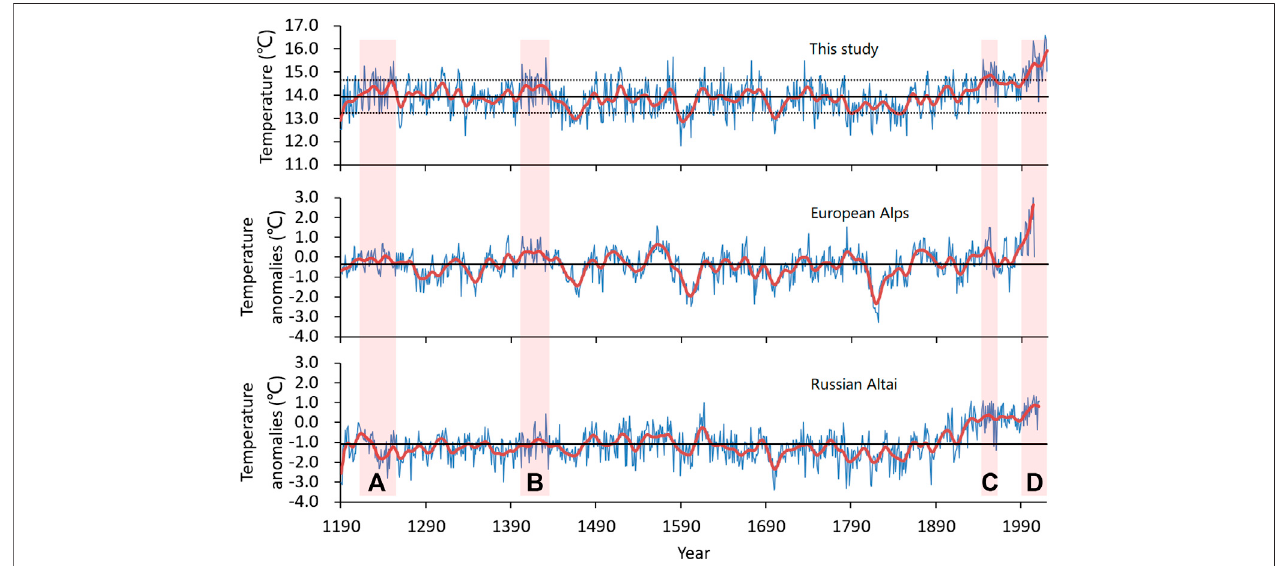
FIGURE 5 | Original (Thick) and 20-year low-pass fi ltered (thin) temperature reconstruction for northern Mongolian Plateau, the European Alps, and Russian Altai. The long-term average of the temperature reconstruction of northern Mongolian Plateau during 1190 – 2019 CE (13.9 ° C). The boxes mark important Asian historical landmarks: (A) Mongol conquests (1210s – 1250s), (B) The rise of Oirat Mongols (1400s – 1430s), (C) the warm period 1940s – 1950s and (D) the warm period 1990s –